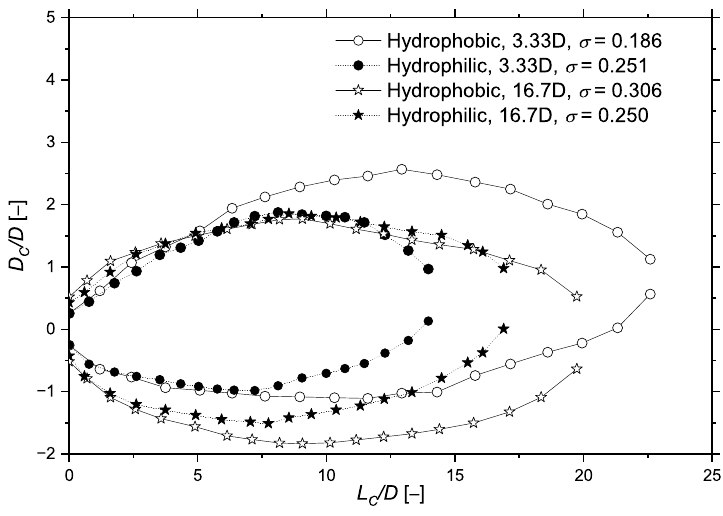
Figure 10. Comparison of cavitation